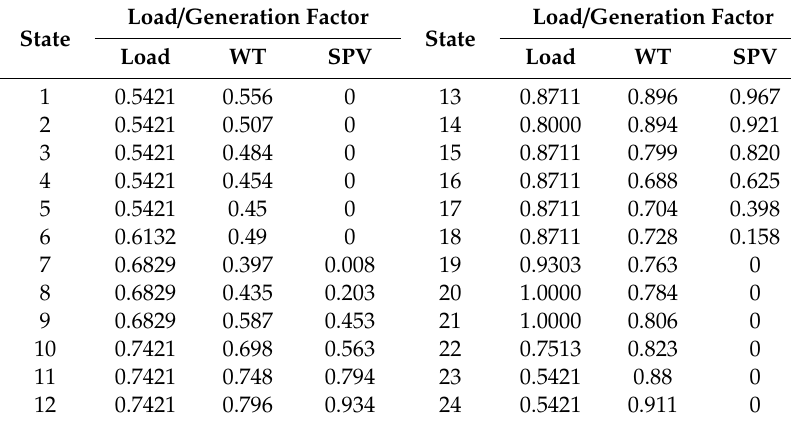
Table 4. Load and generation factors used.